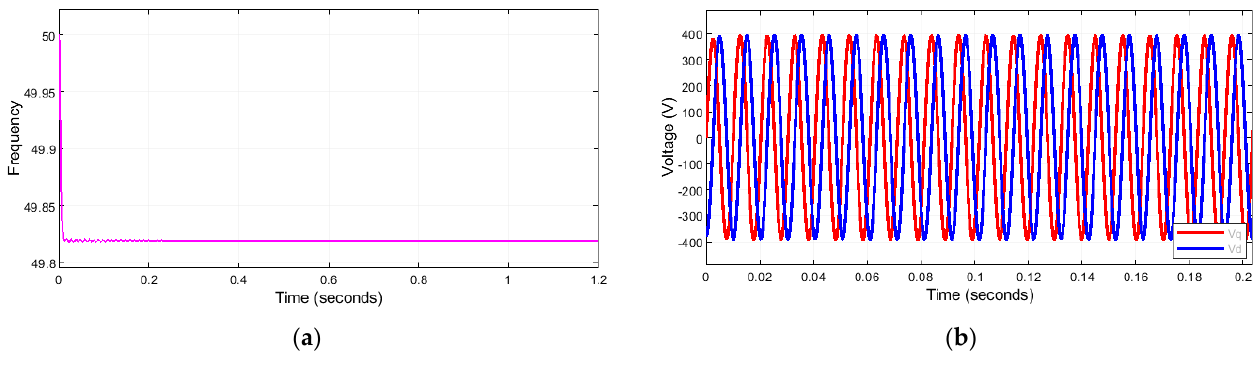
Figure 3. A separate inverter unit: ( a ) Frequency; ( b ) Voltage.